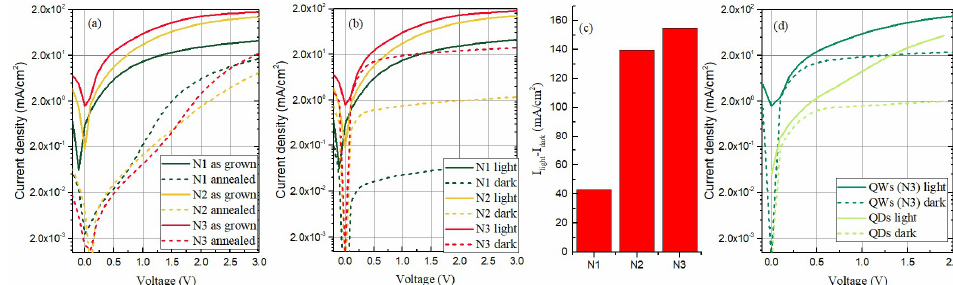
Figure 6. ( a ) I-V properties of the as-grown and annealed films under illumination, ( b ) I-V measure- ments of the as-grown films in the dark and under illumination, ( c ) difference of the current in the light and dark for the as-grown films, and ( d ) comparison of the I-V measurements for the QWs and QDs.